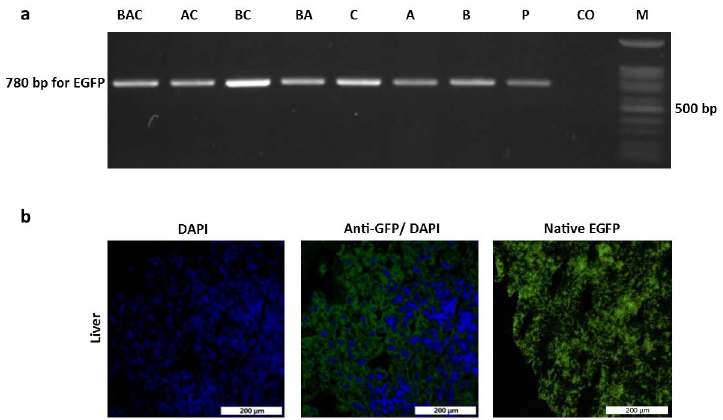
Fig 5. Identification of G 1 transgenic chicks expressing EGFP. (a) PCR analysis was performed on blood DNA from G 1 chicks. DNA samples used as templates for PCR were as follows: Plasmid DNA (pWPXL) (P) as positive control, genomic DNA extracted from the blood of the G 1 progenies of the seven vector-injected (left to right lanes, respectively) and control (Co) groups. Lane M, DNA marker. (b) Ubiquitous EGFP fluorescence is shown in the liver tissue of a transgenic G 1